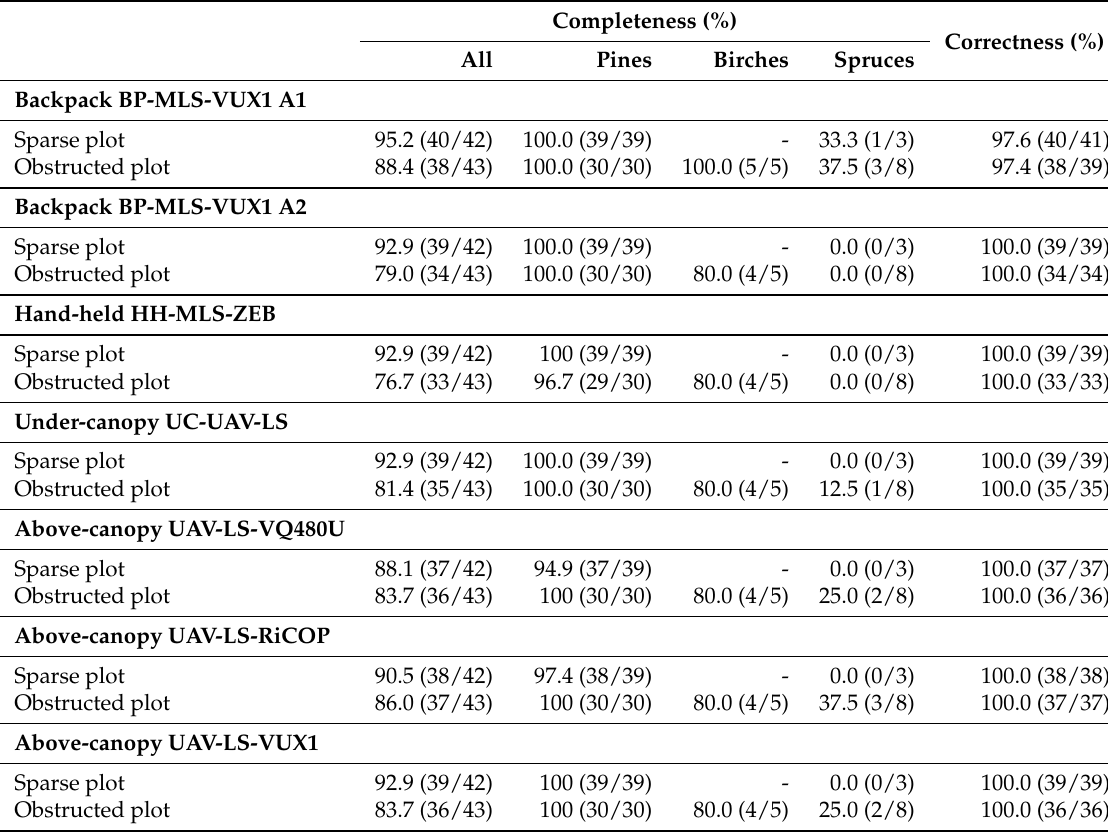
Completeness and correctness (see Equations (3) and (4)) of stem/tree detection for the different methods. Note that we also present the species-wise completeness of tree detection. The number of detected trees is reported inside the